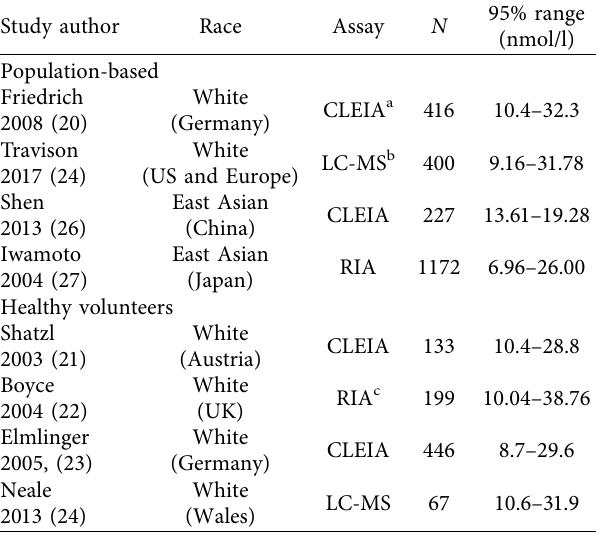
Table 3: Reference ranges for total testosterone in young adult males across different ethnic